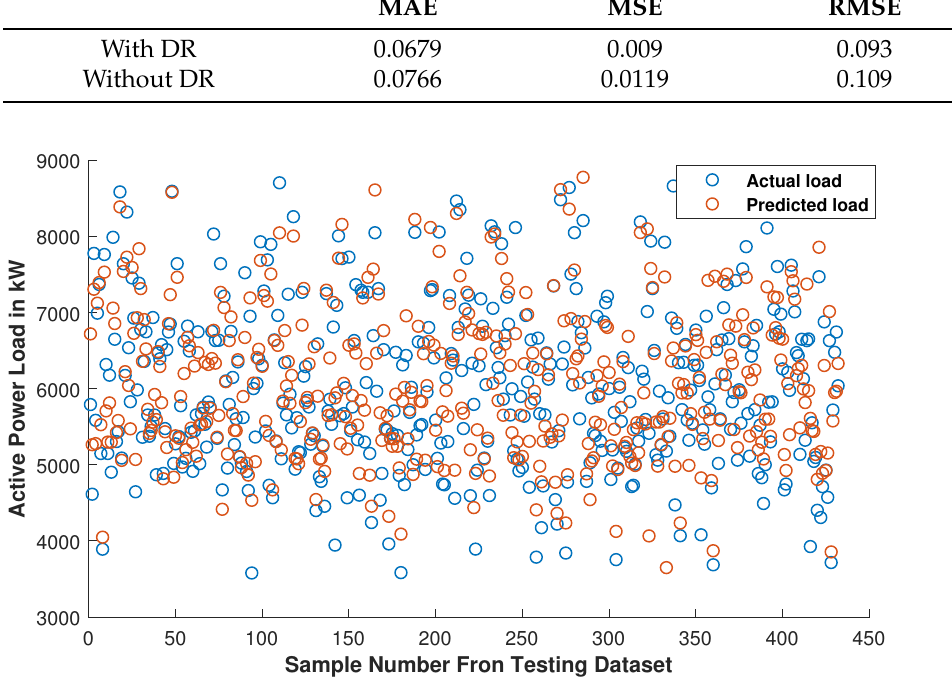
Figure 18. MLR With Dimensionality Reduction: comparison of actual load and predicted load with trained MLR